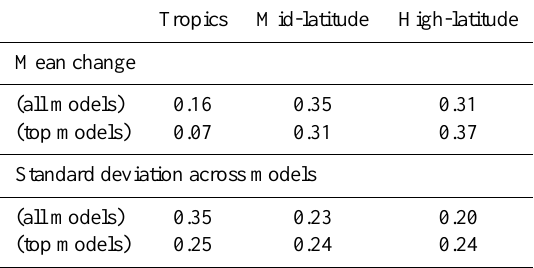
Table 4. Mean and standard deviation across models for future